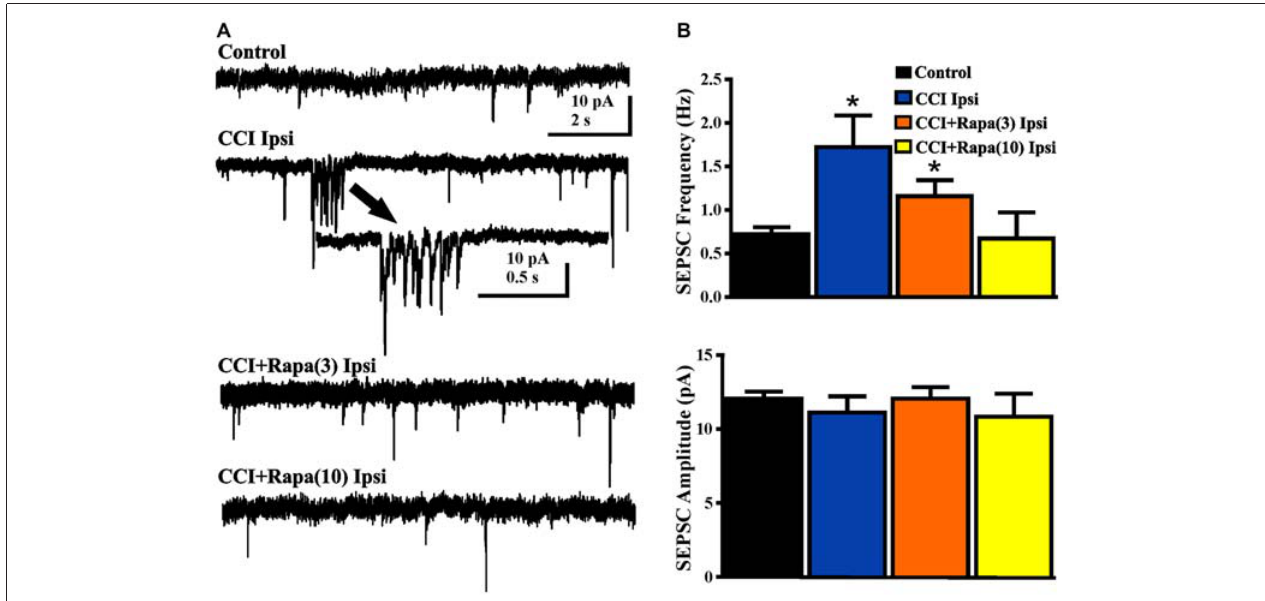
FIGURE 6 | Spontaneous EPSCs (sEPSCs) in dentate granule cells 8–13 weeks post-injury. (A) Representative traces of sEPSCs in dentate granule cells ipsilateral to injury from four treatment groups: sham-operated control, CCI injury + vehicle (CCI Ipsi), CCI injury + 3 mg/kg rapamycin (CCI + Rapa(3)), and CCI injury + 10 mg/kg rapamycin (CCI + Rapa(10)). All recordings were performed in the presence of nominally Mg 2 + -free ACSF containing 30 µ M bicuculline. Arrow indicates expanded example of a burst of sEPSCs in a dentate granule cell from the vehicle-treated CCI group. (B) Mean sEPSC frequency and amplitude in the same treatment groups. Error bars indicate SEM; ∗ p <